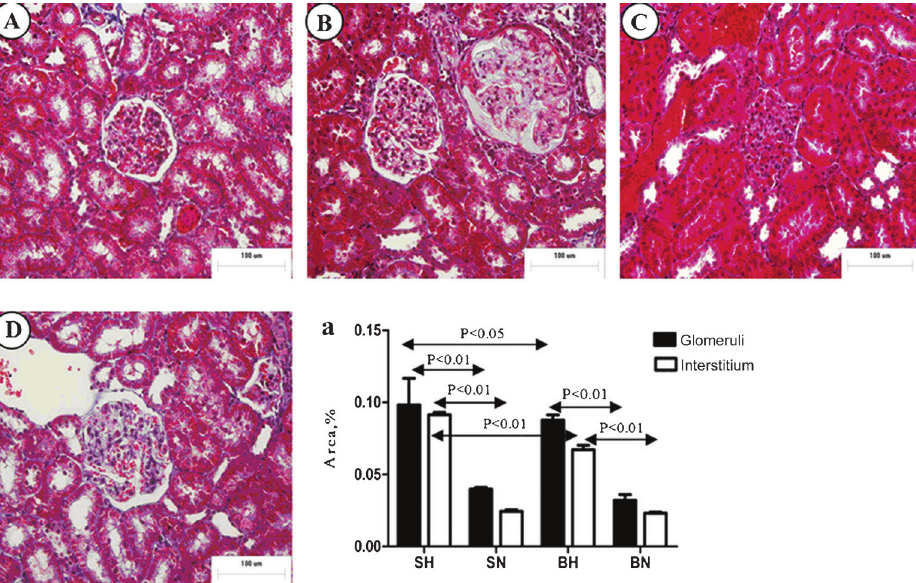
Figure 2. Representative histopathology of renal cortex for all groups; A , SN group; B , SH group; C , BN group; D , BH group. a , Tubulointerstitial and glomerular collagen area fractions were determined by Masson trichrome staining. SN: Dahl salt-sensitive (SS) rats on a normal-salt diet (0.3% NaCl); SH: Dahl SS rats on a high-salt diet (8% NaCl); BN: SS-13 BN rats on a normal-salt diet (0.3% NaCl); BH: SS-13 BN rats on a high-salt diet (8% NaCl). One-way ANOVA was used for statistical